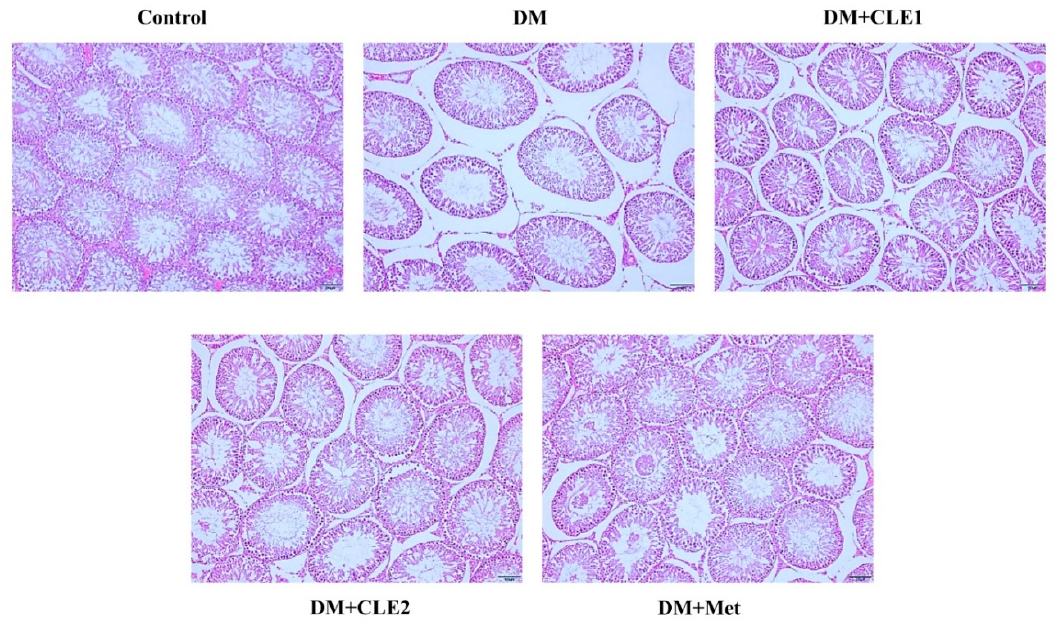
Figure 8. The representatives of the seminiferous tubule sections of each group were stained with hematoxylin and eosin (H&E) in diabetic mice after treatment for 6 weeks ( n = 1). Magnification, 200 ×. DM, diabetes; DM+CLE1, diabetes and 600 mg/kg of C. lentillifera ; DM+CLE2, diabetes and 1000 mg/kg of C. lentillifera ; DM+Met, diabetes and 200 mg/kg of metformin.